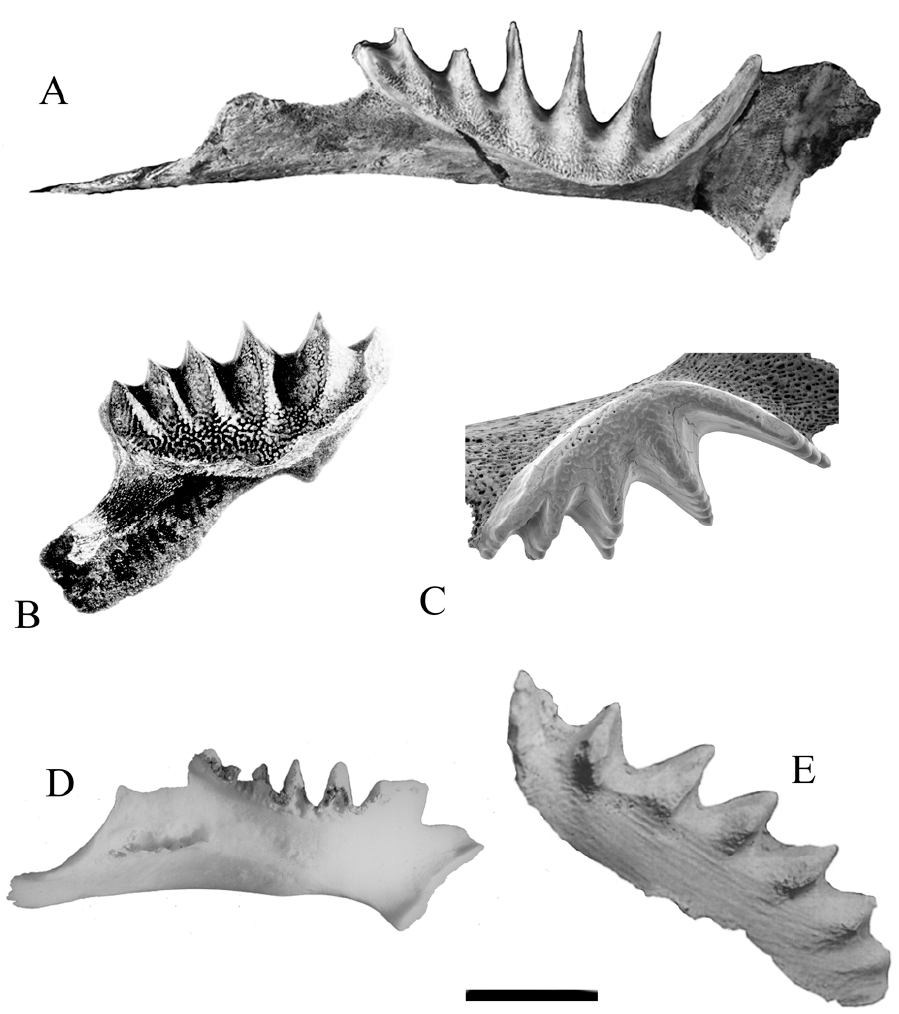
Figure 2. Normal wear in lungfish tooth plates. ( A ) Occlusal view of a large tooth plate of Mioceratodus poastrus AMNH 11322 with shallow interridge facets. ( B ) “ Ceratodus forsteri ” de Vis QMF 15009, post Pliocene, a tooth plate with deep grinding wear. ( C ) A juvenile lower tooth plate of N . forsteri , AN 25998, from the Brisbane River with normal wear. ( D ) Medial view of a tooth plate from Enoggera reservoir with deep facets resulting from the crushing of hard items of food, AN88- 109. ( E ) Severe attrition in a tooth plate of Archaeoceratodus theganus , MV P 160524. Scale bar = 2 cm.